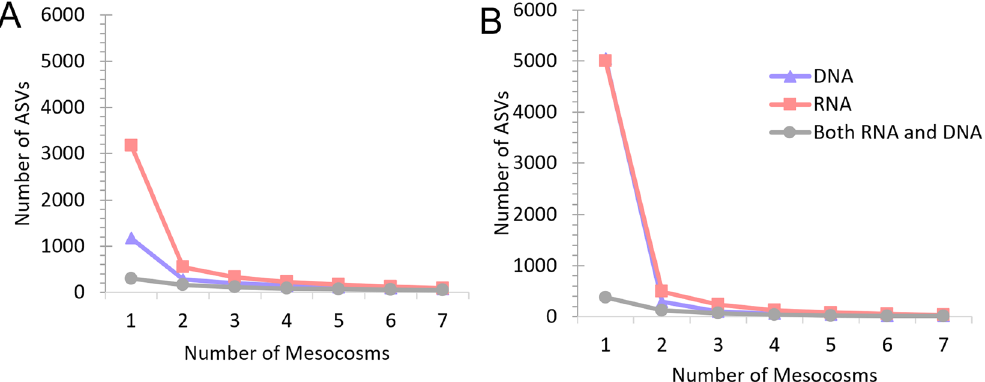
Figure 1. The number of unique sequences (ASVs) detected using the ( A ) 18S marker and ( B ) COI marker for RNA (red), DNA (blue) templates, and found similarly in both RNA and DNA templates (gray) in at least 1, 2, 3, 4, 5, 6, and all 7 of the